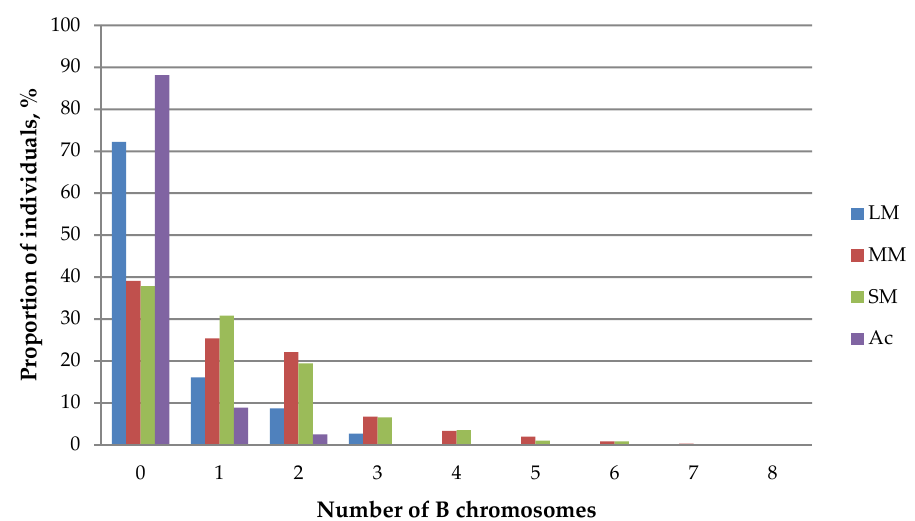
Figure 4. Ratio of A. peninsulae individuals with different numbers of B chromosomes across studied populations. LM: large metacentrics; MM: medium metacentric SM: small metacentric Ac: acrocentric.